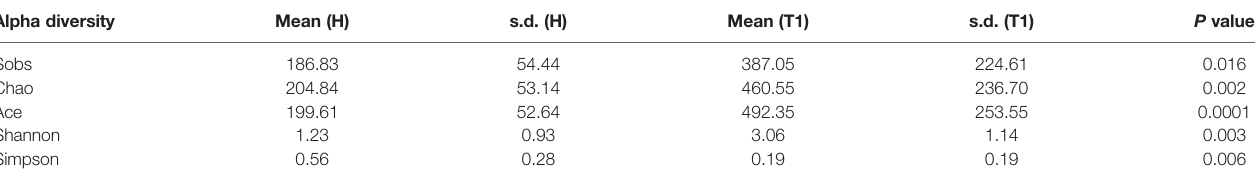
T1, the fi rst time point sample of patients; H, healthy controls; s.d., standard